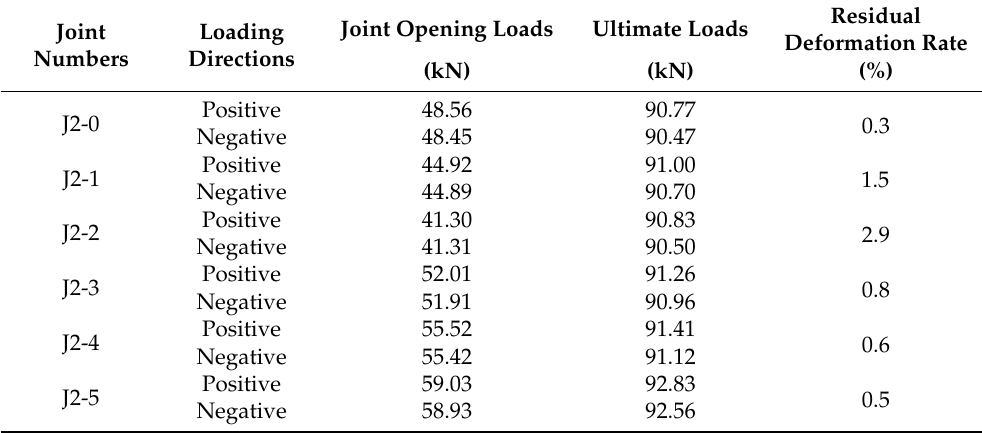
Table 6. Key data of joint load–displacement curves.